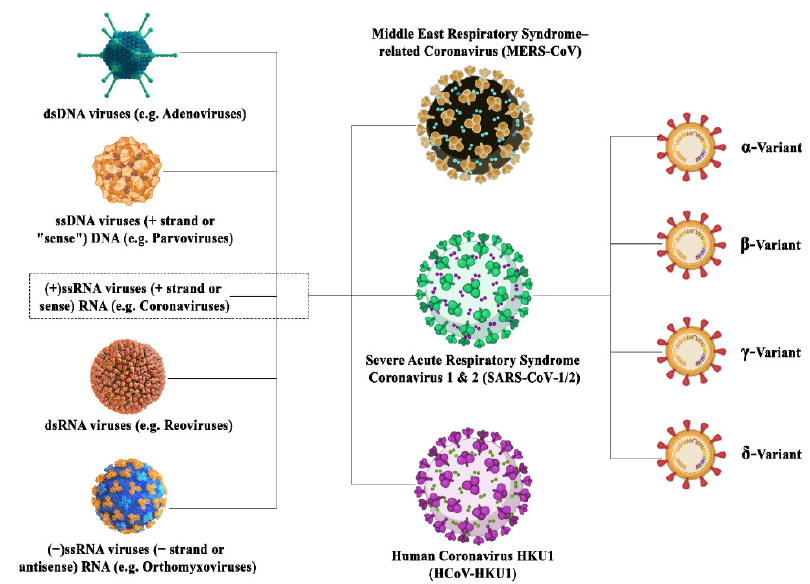
Figure 1. Illustration depicting the family inclusions of different coronavirus variants surged in this century with their subtypes.